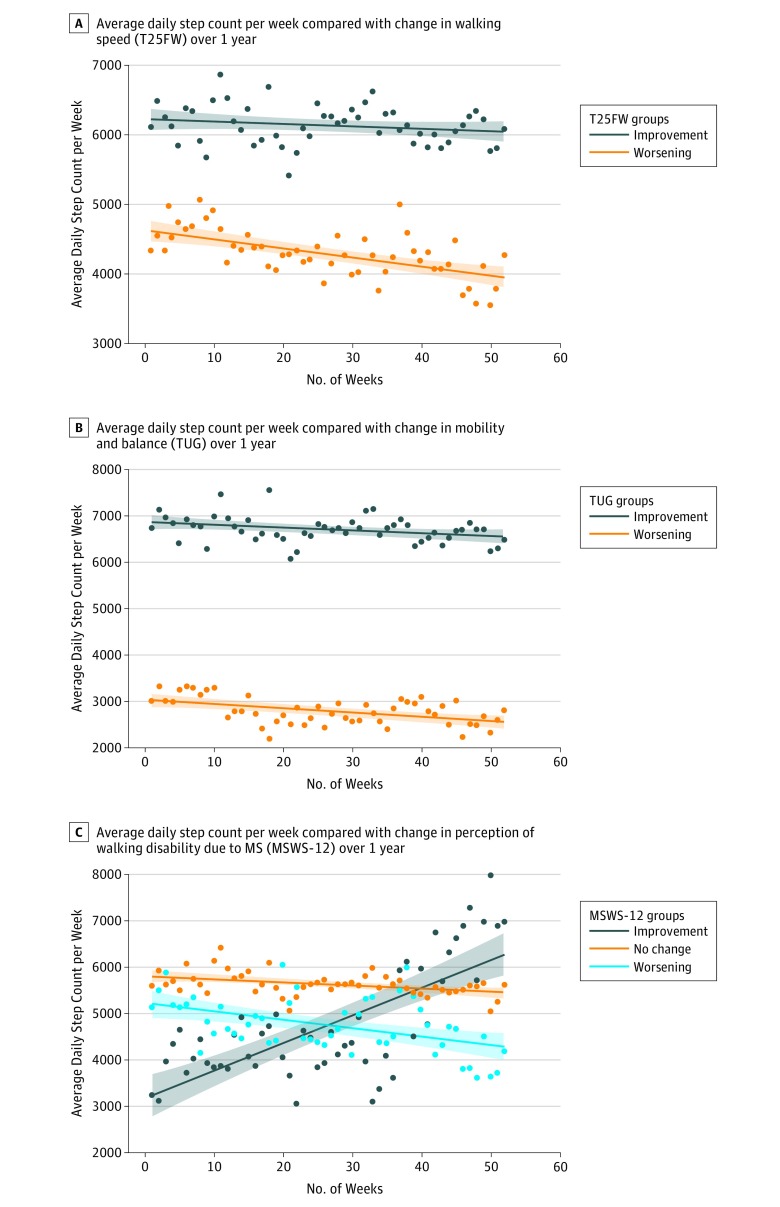
Average Daily Step Count per Week Compared With the Change in Clinic-Based and Patient-Reported OutcomesEach point reflects the average daily step count averaged per week (using weighted means) of individuals with changes in clinic-based and patient-reported outcomes from baseline to 1-year follow-up. The shaded areas represent the 95% CIs for the regression line. MSWS-12 indicates 12-item Multiple Sclerosis Walking Scale; TUG, Timed-Up-and-Go; and T25FW, Timed 25-Foot Walk.